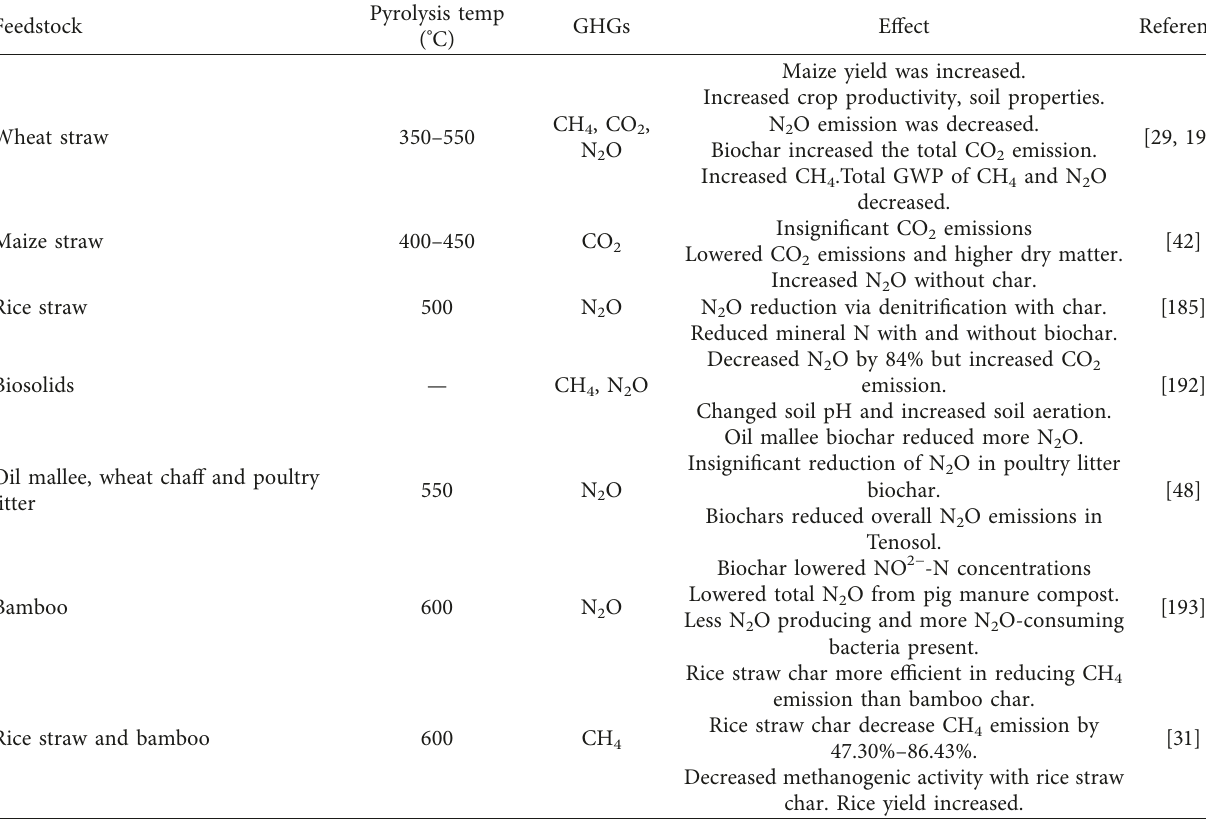
Table 6: GHG abatement potential and effect of biochar